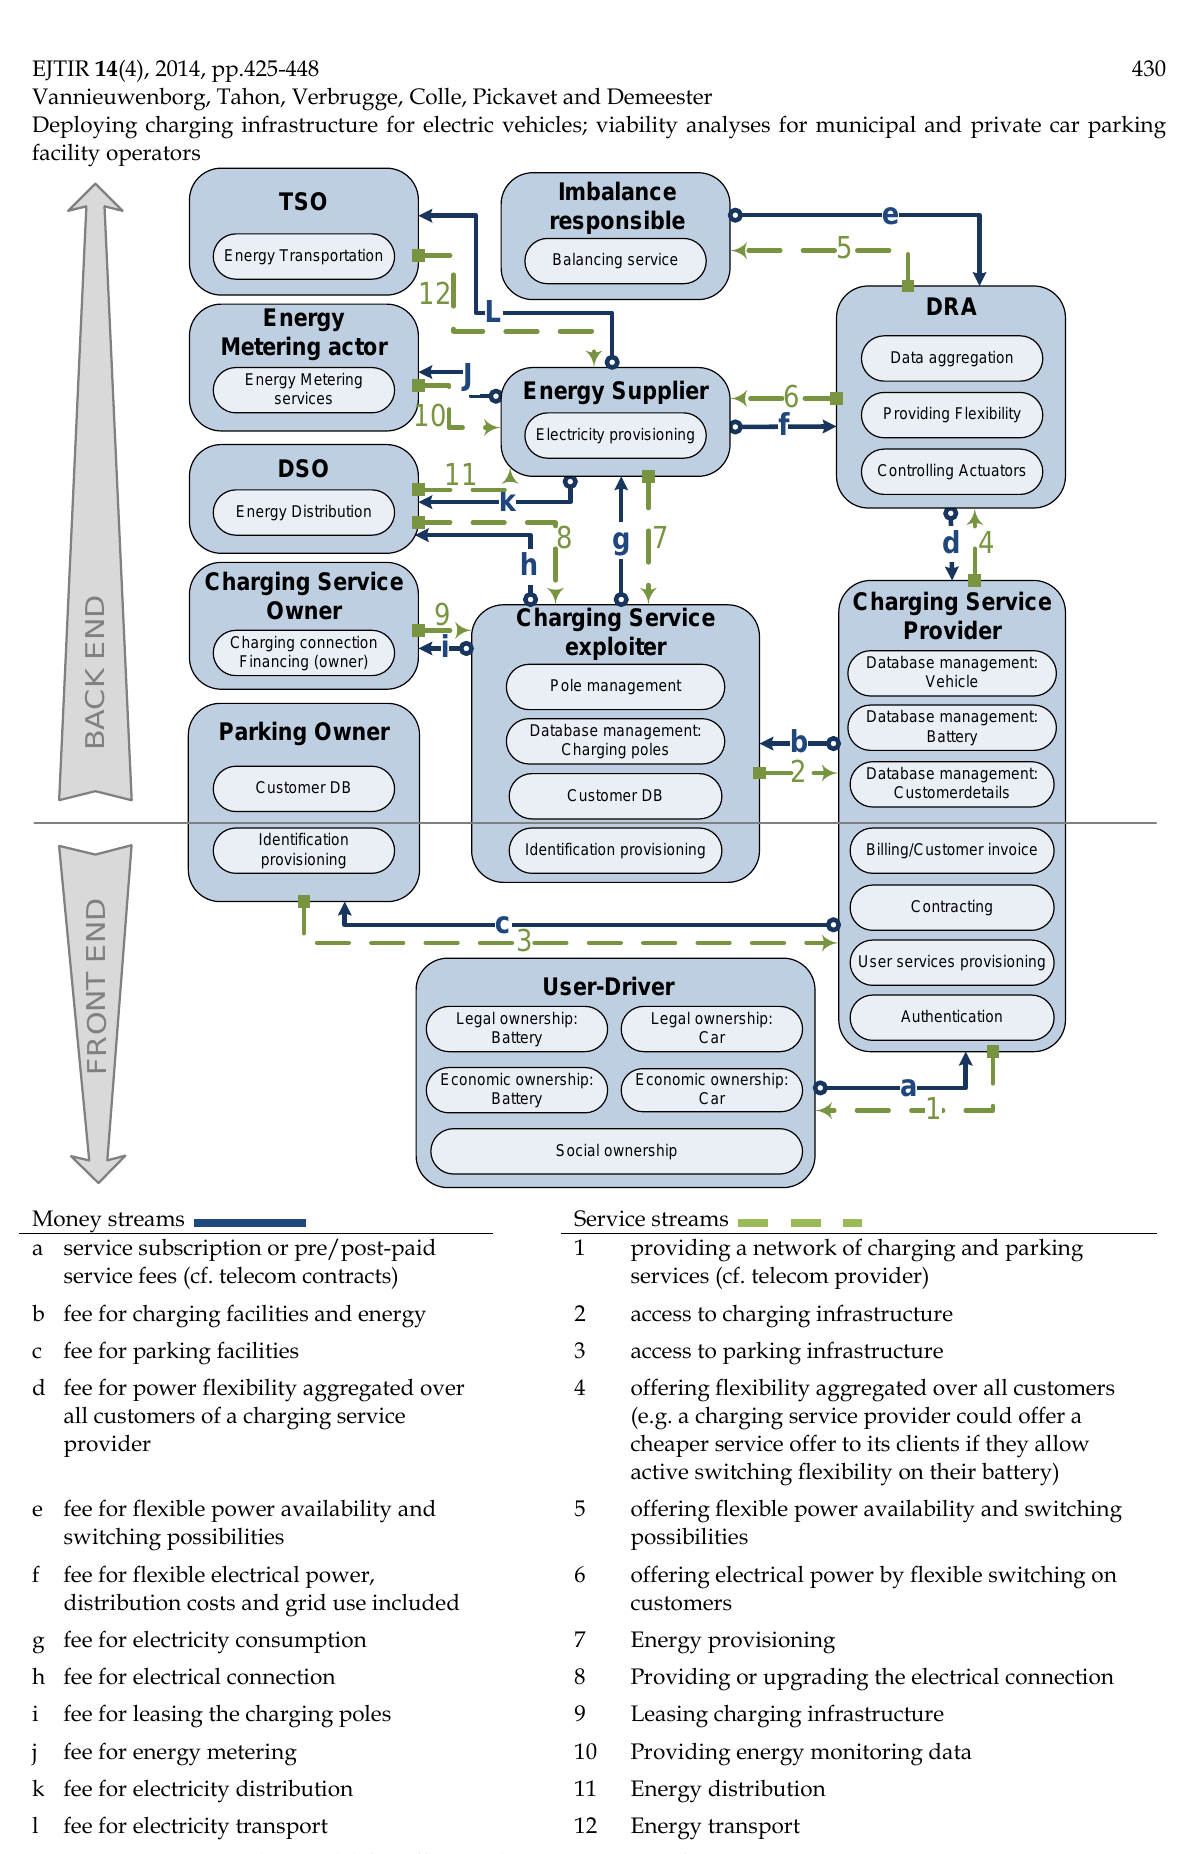
Figure 1. Market model for offering charging services for